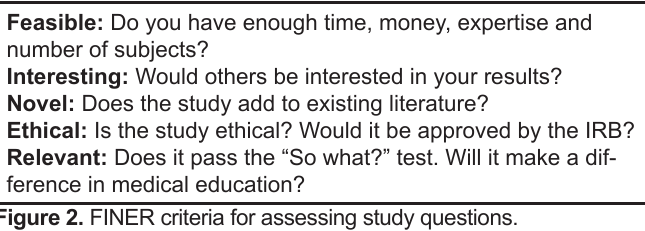
Figure 1. Example of a research question in PICOT formatting. PICOT , population, intervention, comparison, outcomes, time frame.